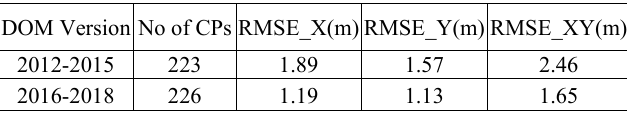
Table 2. The planner accuracy comparison of the